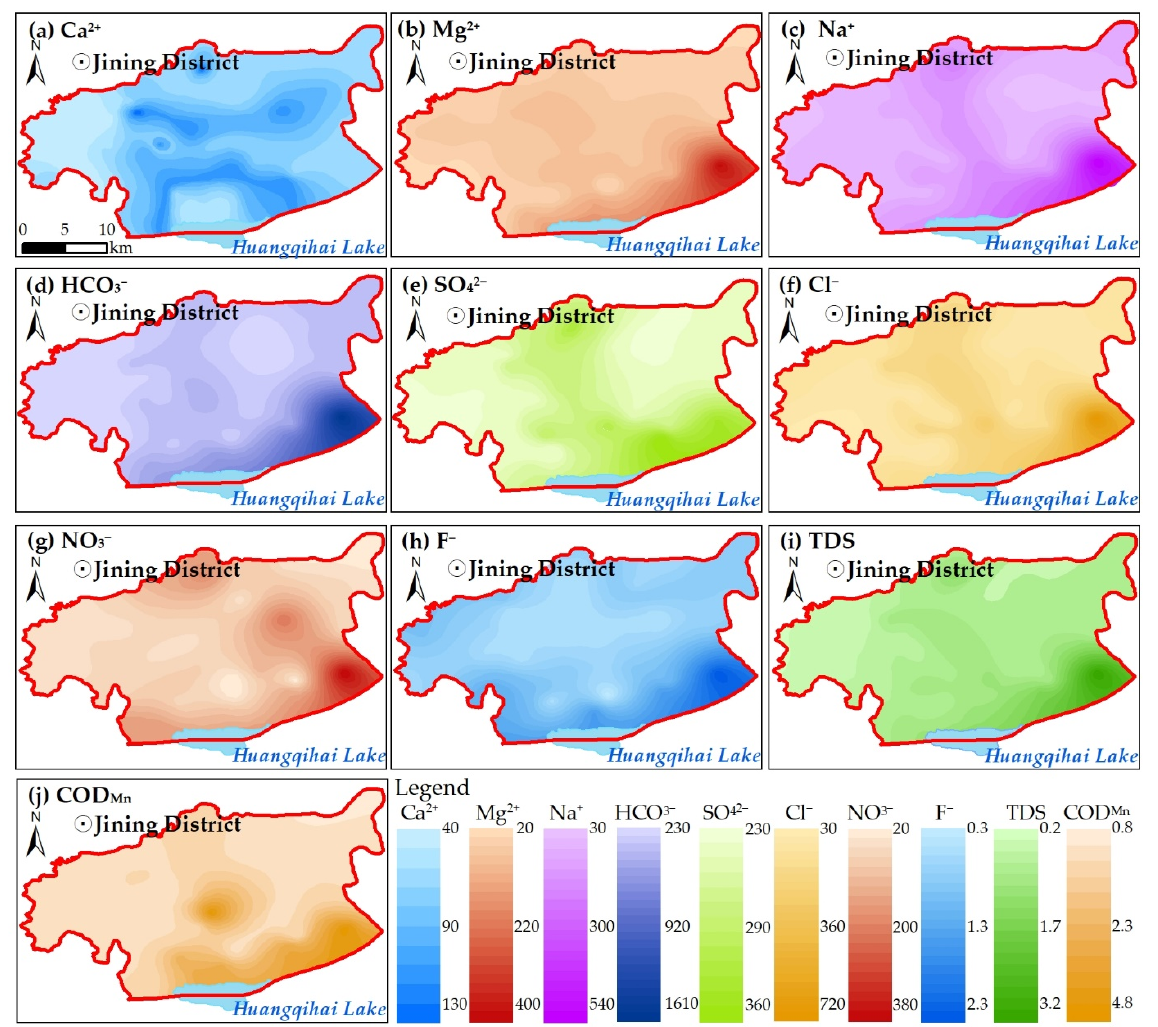
Figure 3. Spatial distribution of hydrochemical indices ( a – j ). The unit of TDS is g/L and the units of other indices are mg/L.